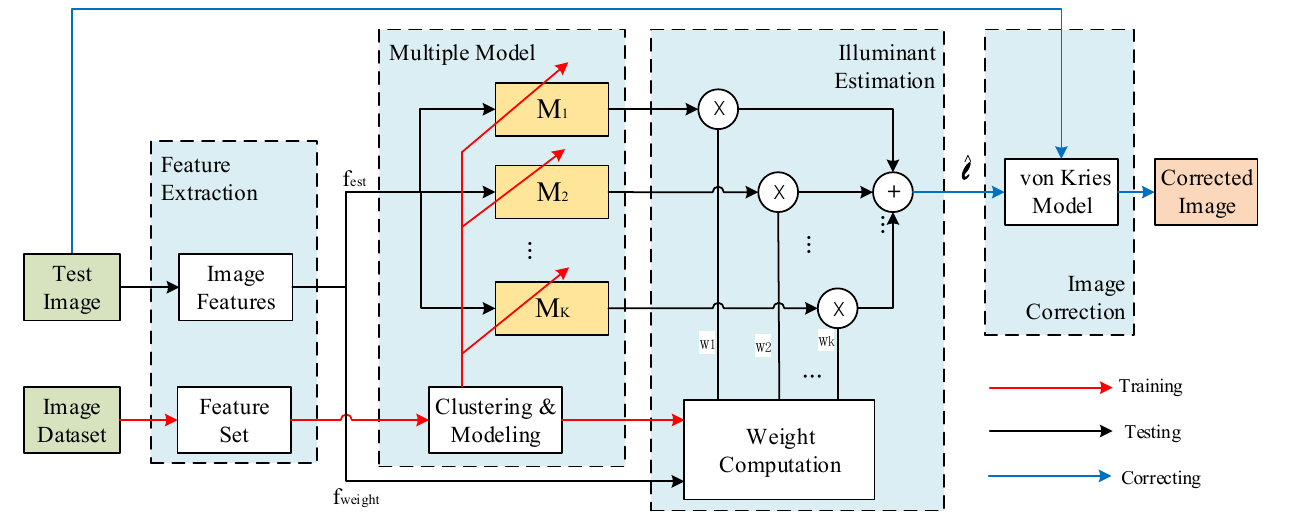
Figure 1. The framework of the proposed method. For a given test image, the related image features are extracted and used for estimating candidate illuminant colors and obtaining fuzzy weights, then the final estimated illuminant can be produced by weighting all outputs of multiple